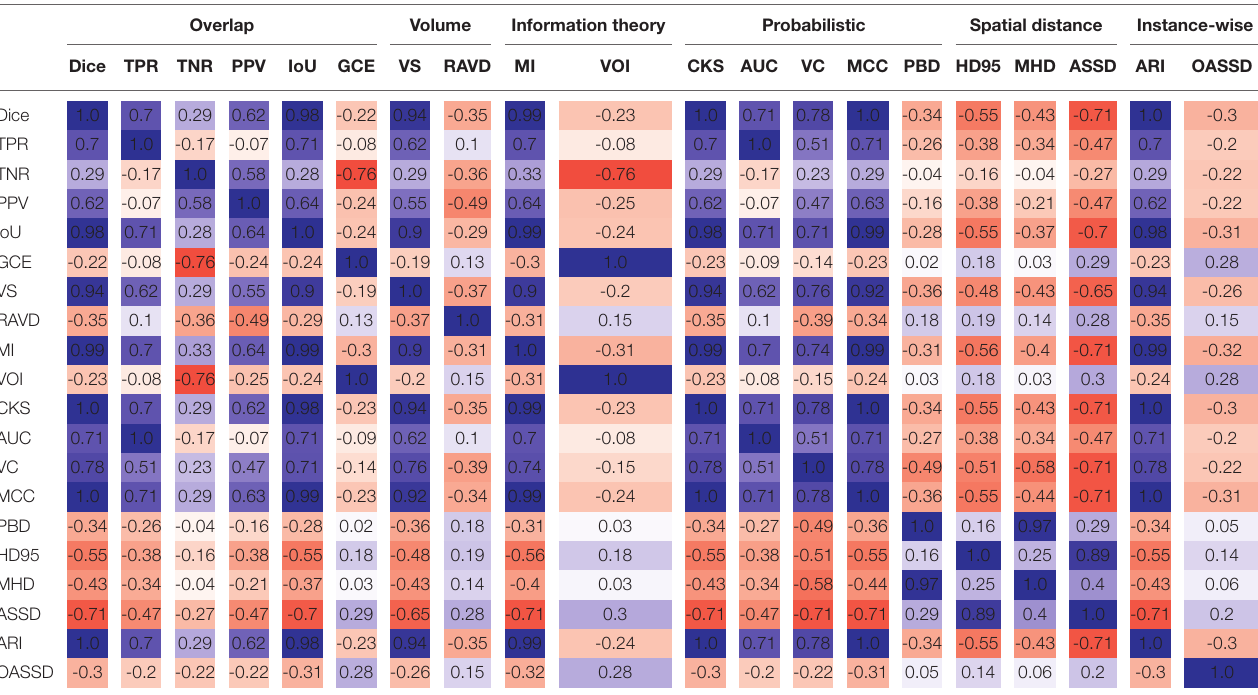
TABLE 9 | Metrics correlation matrix for glioblastoma segmentation.